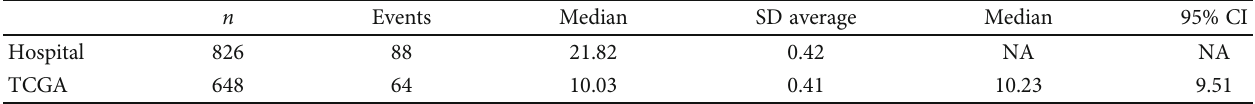
Table 10: Kaplan-Meier survival adjustment of the Hospital set and TCGA.